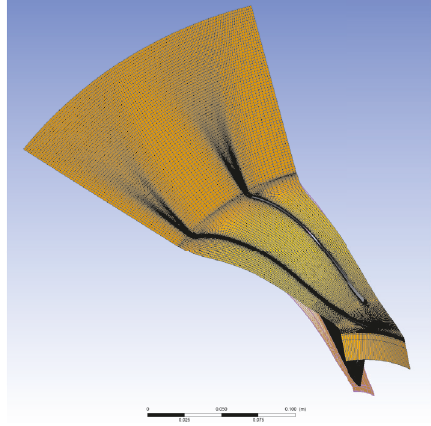
Figure 7: Simulation